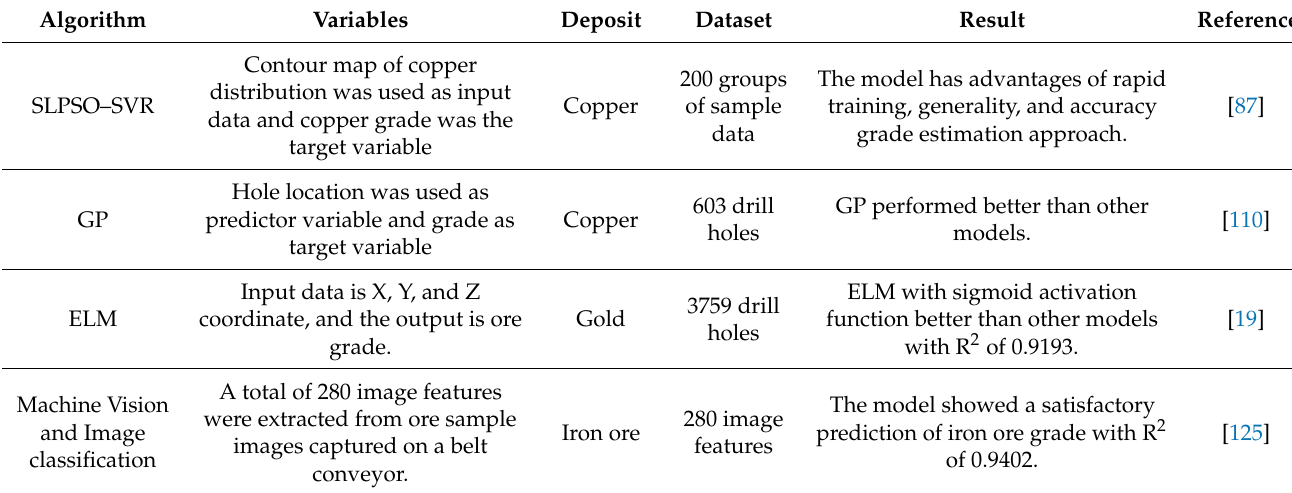
Table 6. Sample case studies of emerging machine learning techniques for mineral resource